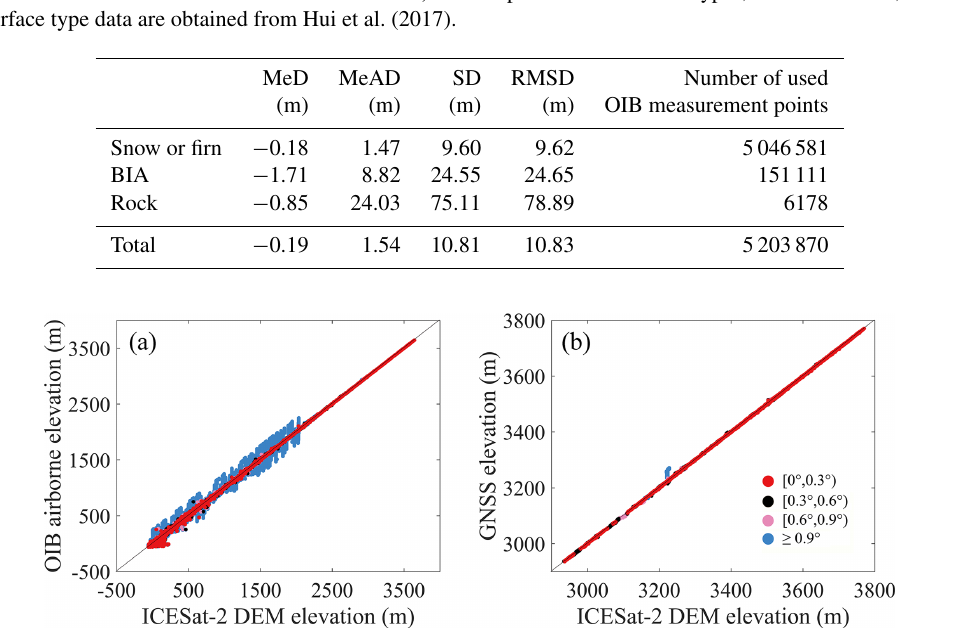
Figure 9. Scatter plots of ICESat-2 DEM elevation and OIB airborne elevation (a) and GNSS elevation (b) . The surface slopes are distin- guished in different colours, as shown in the figure legend.